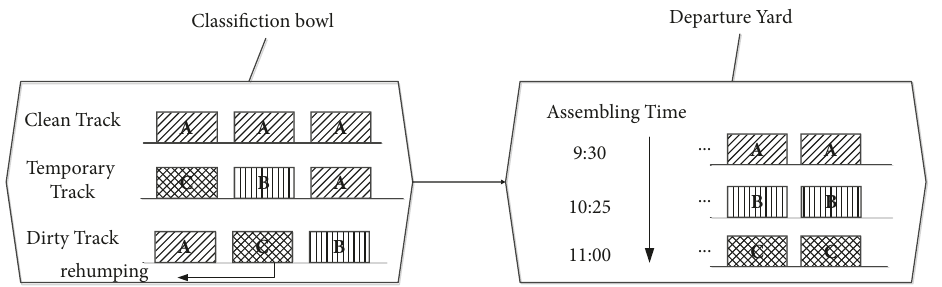
Figure 2: Clean track, temporary track, and dirty